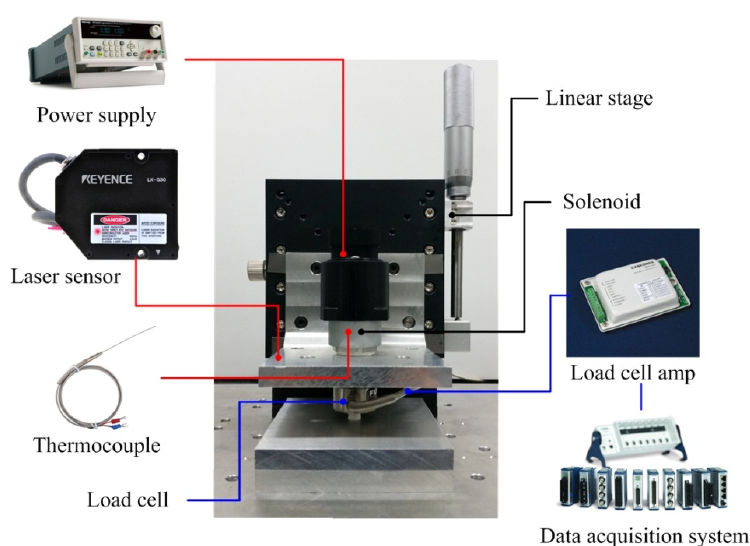
Figure 13. Experimental setup for attraction force and saturation temperature.